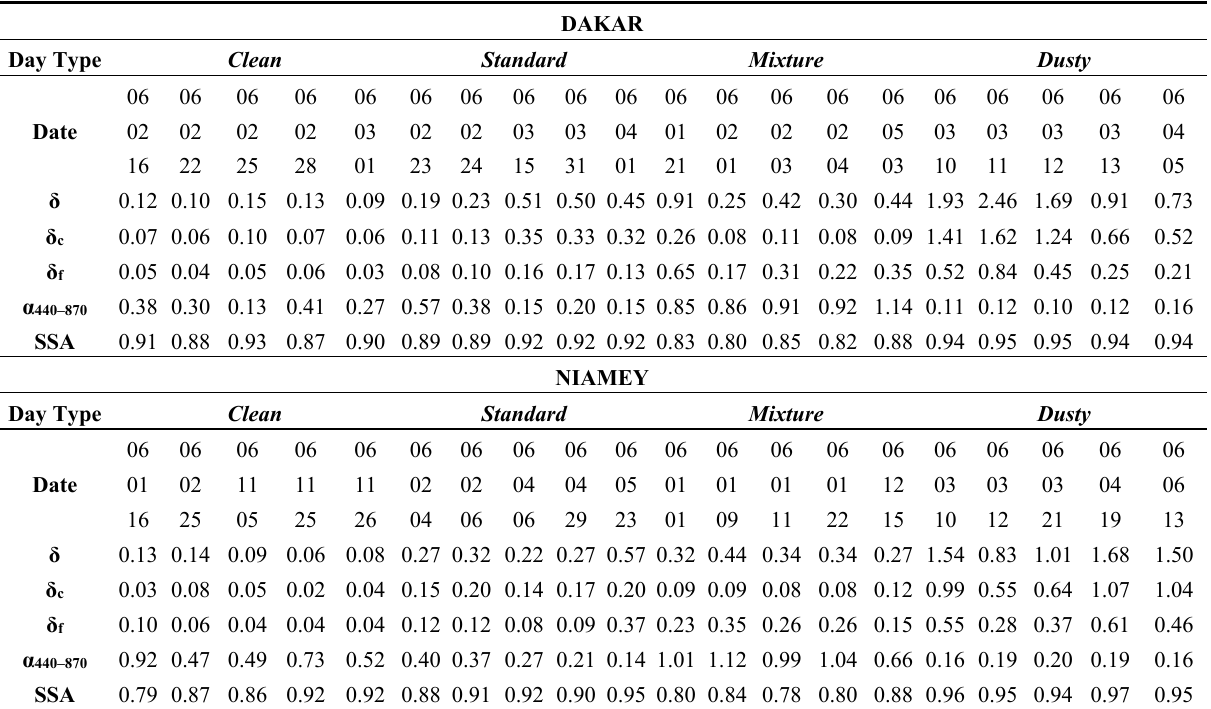
Table 2. Daily averaged Aerosol Robotic Network (AERONET) observations for each selected day ( clean , standard , mixture or dusty ) in Dakar (top table) and Niamey (bottom table). The parameters are total aerosol optical depth (AOD) ( δ ), coarse mode AOD ( δ c ), fine mode AOD ( δ f ), Ångström coefficient ( α 440–870 ), and single scattering albedo (SSA), all at 550 nm except the Ångström coefficient. For the “Date” line, the first line corresponds to the year, the second to the month, and the third to the day